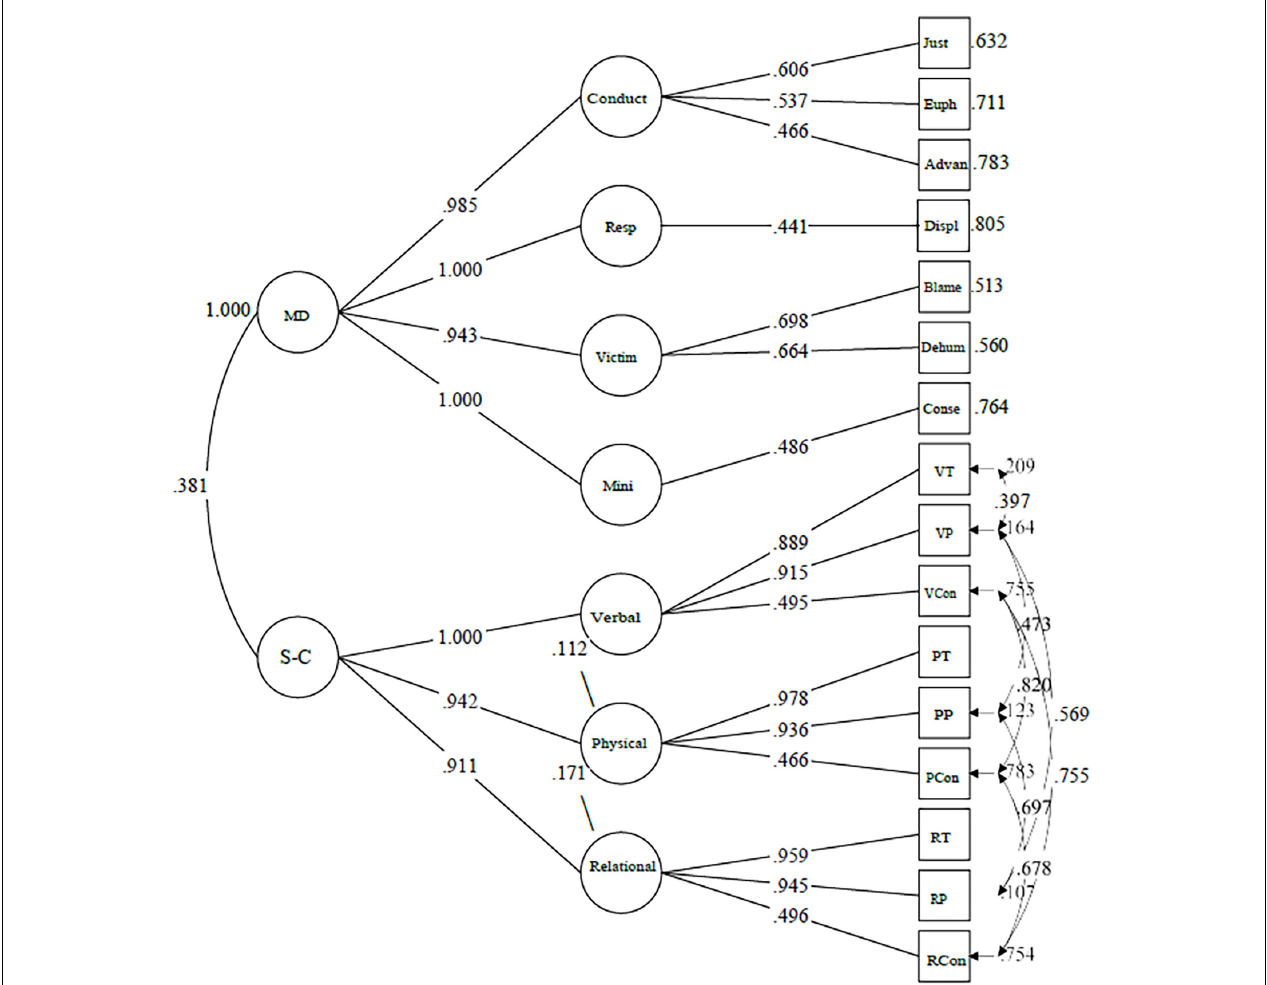
FIGURE 1 | Moral dimensions, two latent factors model. Only significant paths ( p < 0.05) are displayed in the figure. Standardized indices. MD, Moral Disengagement, S-C, Socio-conventionality of the moral rules for aggression; Conduct, conduct restrictuding mechanisms, Resp, responsibility restructuring mechanisms, Victim, victim restructuring mechanism, Mini, consequence minimization moral disengagement mechanism, Just, moral justification mechanism, Euph, euphemistic labeling mechanism,Advan, advantagious comparison mechanism, Displ, responsibility displacement mechanism, Blame, victim blame mechanism, Dehum, dehumanization mechanism; VT, verbal violence teacher’s permission, VP, verbal violence principal’s permission, VCon, verbal violence context dependence; PT, physical violence teacher’s permission, PP, physical violence principal’s permission, PCon, physical violence context dependence; RT, relational violence teacher’s permission, RP, relational violence principal’s permission, RCon, relational violence context